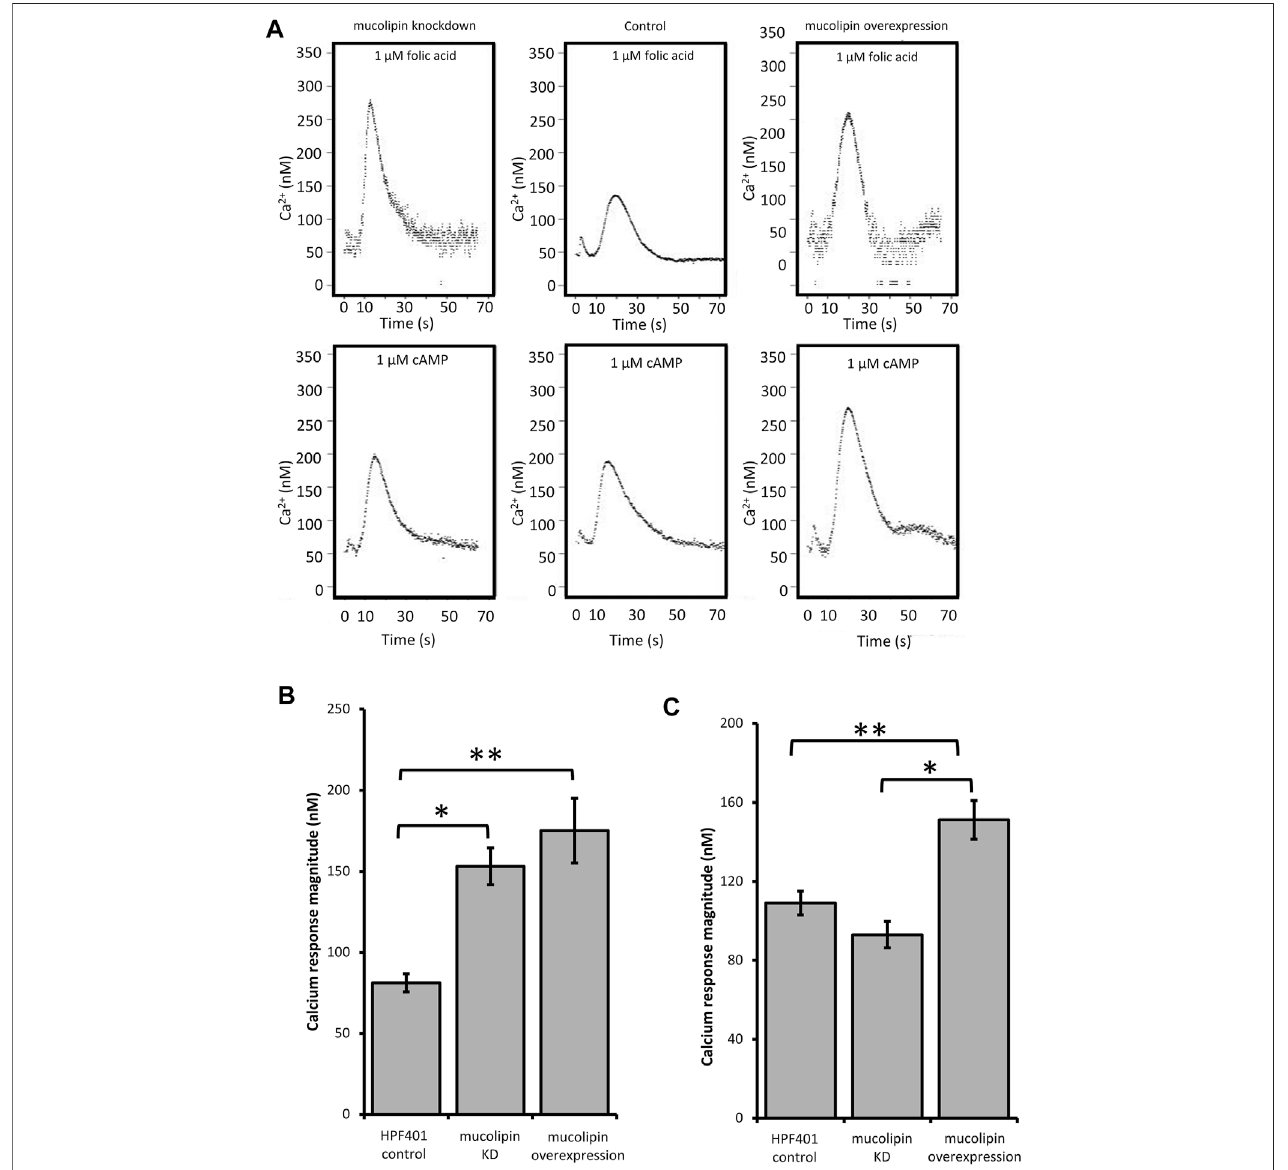
FIGURE 4 | Cytosolic calcium responses to cAMP and folic acid stimulation. (A) Representative real time recordings of cytoplasmic Ca 2+ responses to chemoattractants.Upperpanel:RealtimerecordingsofCa 2+ responsesto1 μ Mfolateinvegetativecells.Lefttoright:mucolipinKD(knockdown),HPF401controlstrain and mucolipin overexpression. Lower panel: Real time recordings of Ca 2+ responses to 1 μ M cAMP in cells at 7 h development. Left to right: as above. Recordings beganat0 sand thestimuluswasinjected immediatelyafter.Thesmallpeak preceding theCa 2+ response isdue toaCa 2+ responsetothemechanical stimulusof chemoattractant injection, which has no effect on the chemoattractant responses (Nebl and Fisher, 1997). (B) Mean calcium response magnitudes in vegetative cells stimulationwith 1 µM folicacid. Ca 2+ responsemagnitudes (Ca 2+ nM) weremeasuredin mucolipin KD,mucolipin overexpression and control strainHPF401.There was no correlation with copy number so data from strain groups was pooled and the means compared. Both knockdown and overexpression of mucolipin signi fi cantly enhancesthemagnitude oftheresponsecomparedtothecontrolstrainHPF401(* p =3.15×10 – 5 ,** p =4.7×10 – 4 ).Meanswerecompared using anindependent one- tailed t -test.Errorsarestandarderrorsofthemean.Individualstrainsweretestedin3 – 9independentexperimentsin fi vemucolipinoverexpression( n =13),sixmucolipin knockdown strains ( n = 30) and control strain HPF401 ( n = 12), and all experiments from each strain group were pooled to determine the mean. (C) Mean calcium response magnitudes (Ca 2+ nM) in developed cells stimulated with 1 µM cAMP. Ca 2+ response magnitudes were measured in overexpression, knockdown and control strainHPF401.Cellsweredeveloped to7 hinMED-DB.Overexpressionofmucolipinincreases theresponse magnitudesigni fi cantlycomparedtoboth controlHPF401 and knockdown strains (* p = 1.33 × 10 – 6 , ** p = 5,928 × 10 – 4 ). knockdown of mucolipin has no effect on response magnitude in developed cells when compared to wildtype ( p = 0.083). Means were compared using an independent one-tailed t -test. Errors are standard errors of the mean. Individual strains were tested in 2 – 9 independent experiments and all experiments were pooled to determine the mean. Mucolipin overexpression eight strains ( n = 37), mucolipin knockdown seven strains ( n = 33), control HPF401 ( n = 12).